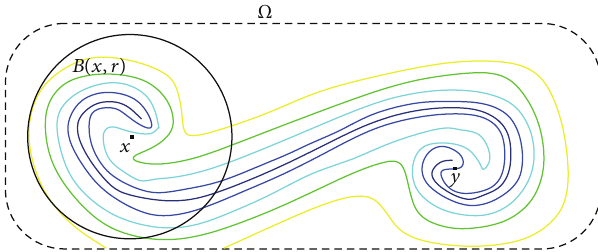
Figure 9: A function that is Vodopyanov-Goldstein monotone, but is not Cone